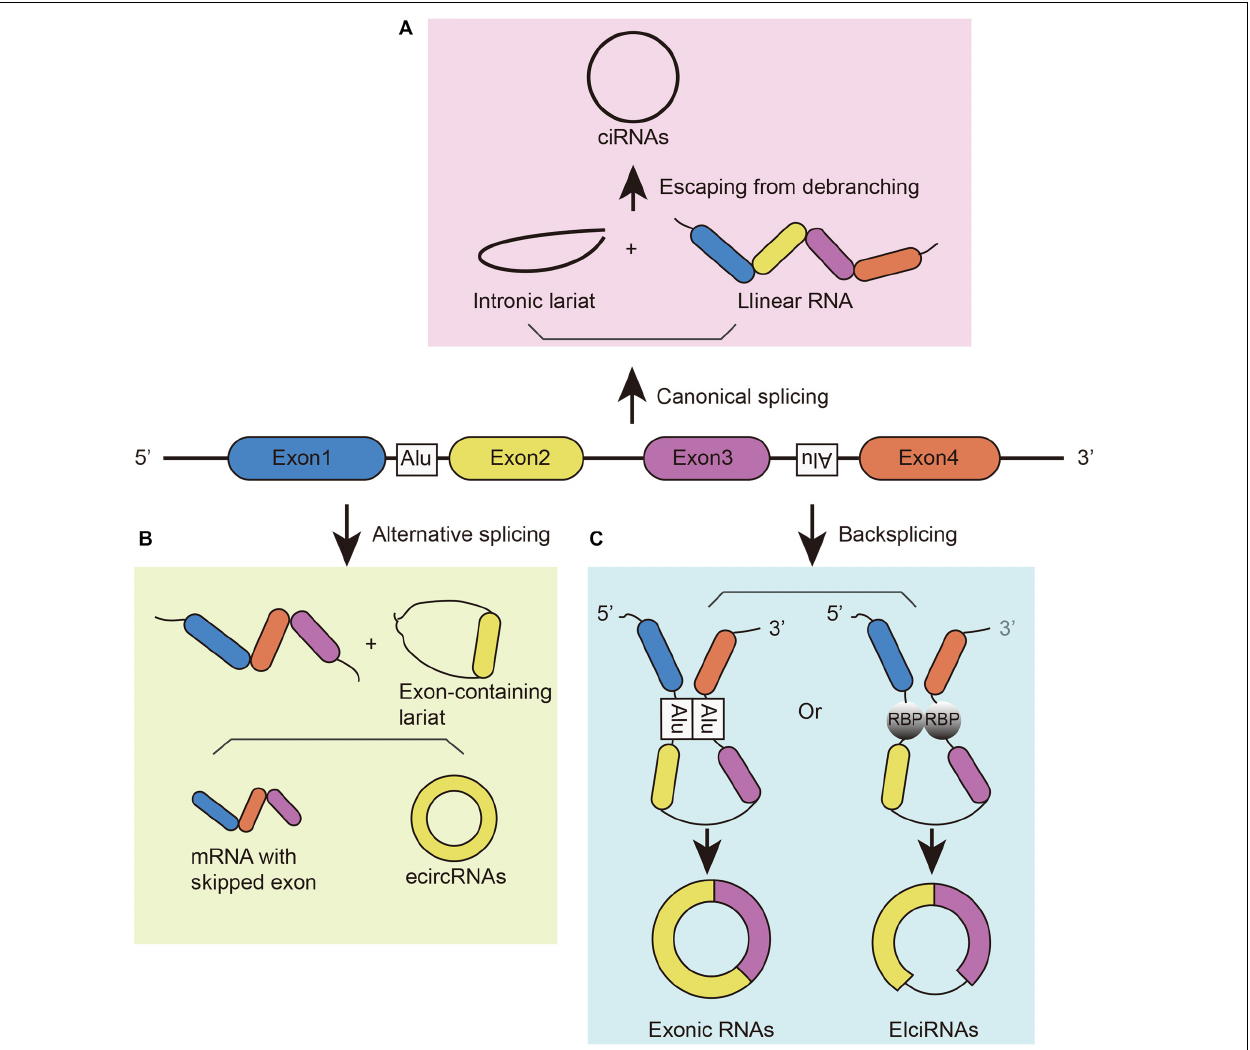
FIGURE 1 | The biogenesis of circRNAs. (A) CiRNAs are generated from intronic lariat precursors that escape from the debranching step of canonical linear splicing. (B) EcircRNAs can be generated from exon-containing lariats created by an exon-skipping event during linear splicing. (C) CircRNAs can be generated from back-splicing mediated by inverted repeat elements and trans -acting RNA binding proteins.